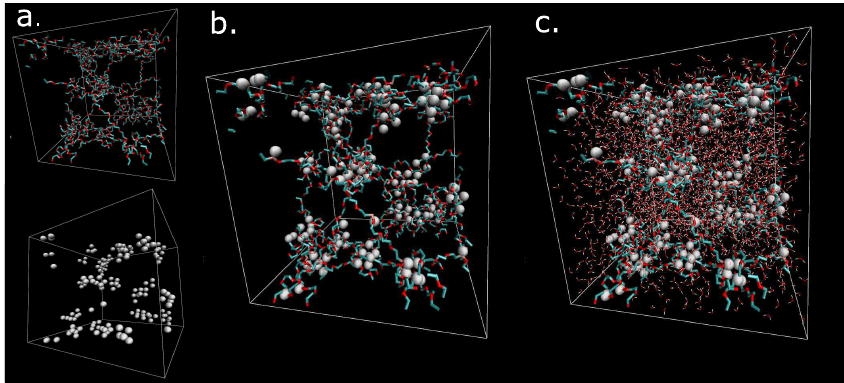
Figure 1. Visualization of the dry network of network structure; ( a ) white- physical crosslinks; cyan-red chains hydrophilic PEG chains; ( b ) Physical network from components from figure a; ( c ) solvated box. Box is cubic with side 5 nm.